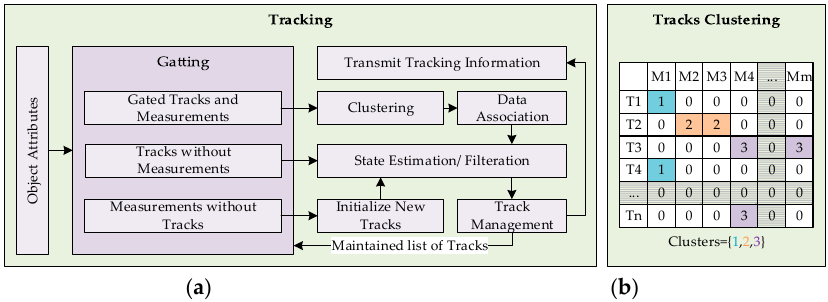
Figure 6. ( a ) Tracking module architecture; ( b ) Clustering example of joint associated events with tracks T and measurements M.